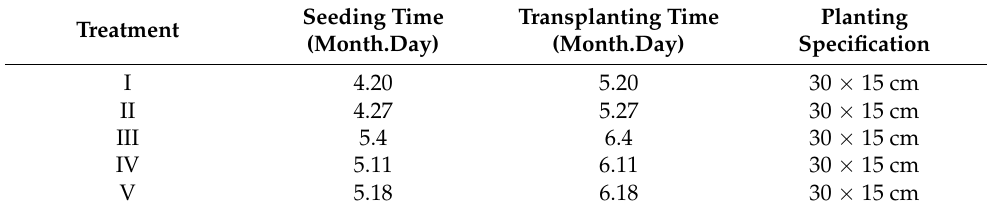
Table 3. The rice sowing date and planting